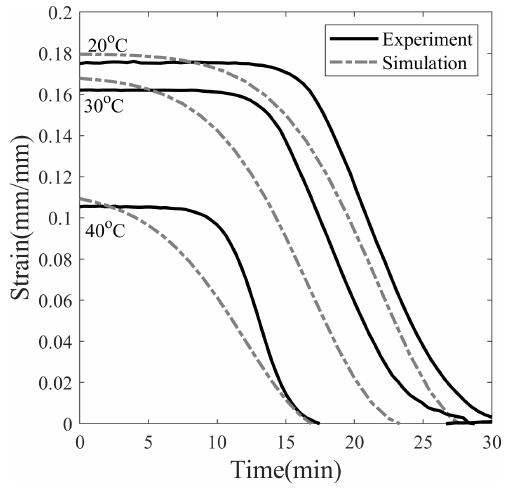
Figure 14. Shape recovery of SMP on heating at 4 °C/min after the isothermal recovery step at three different programming temperatures: 20, 30, and 40